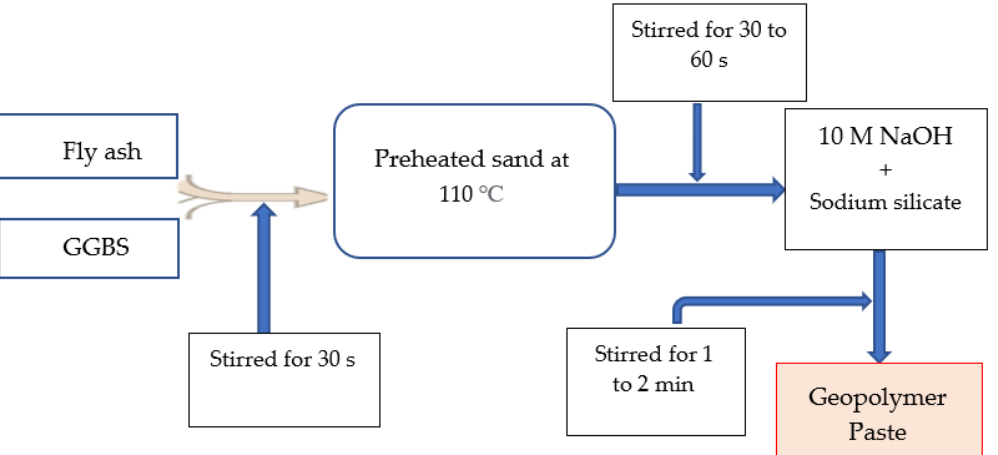
Figure 6. The experimental concept of the phase 1 geopolymer paste.